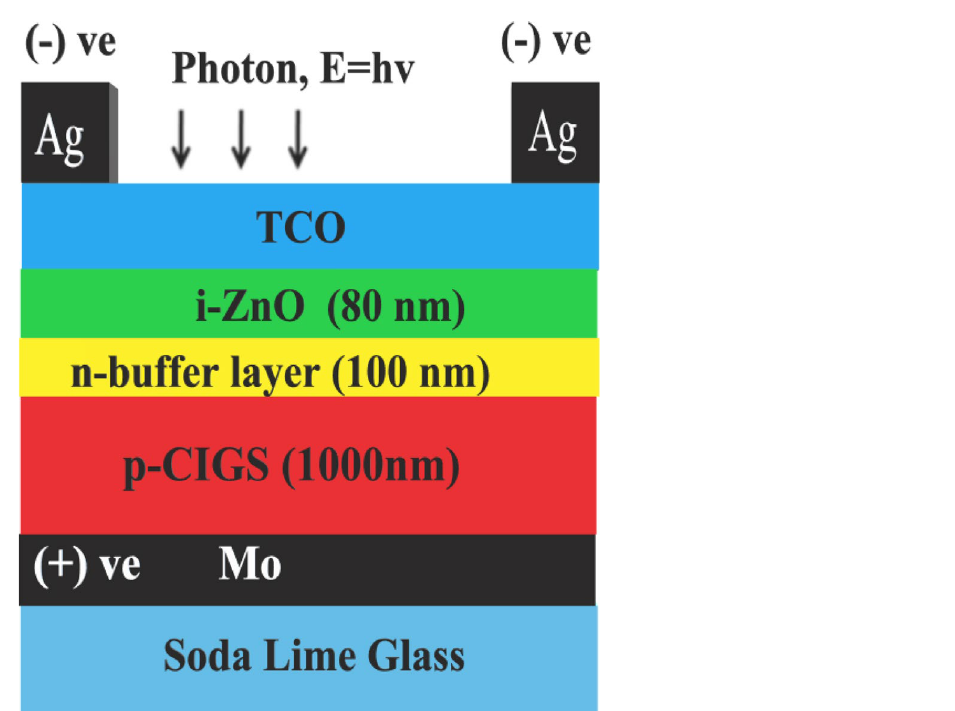
Figure 1. Preparation of Ag 2 S nanoparticles/ZnO NRAs nanoparticles using SILAR technique (yellow circles = Ag + and black circles = S 2− ).